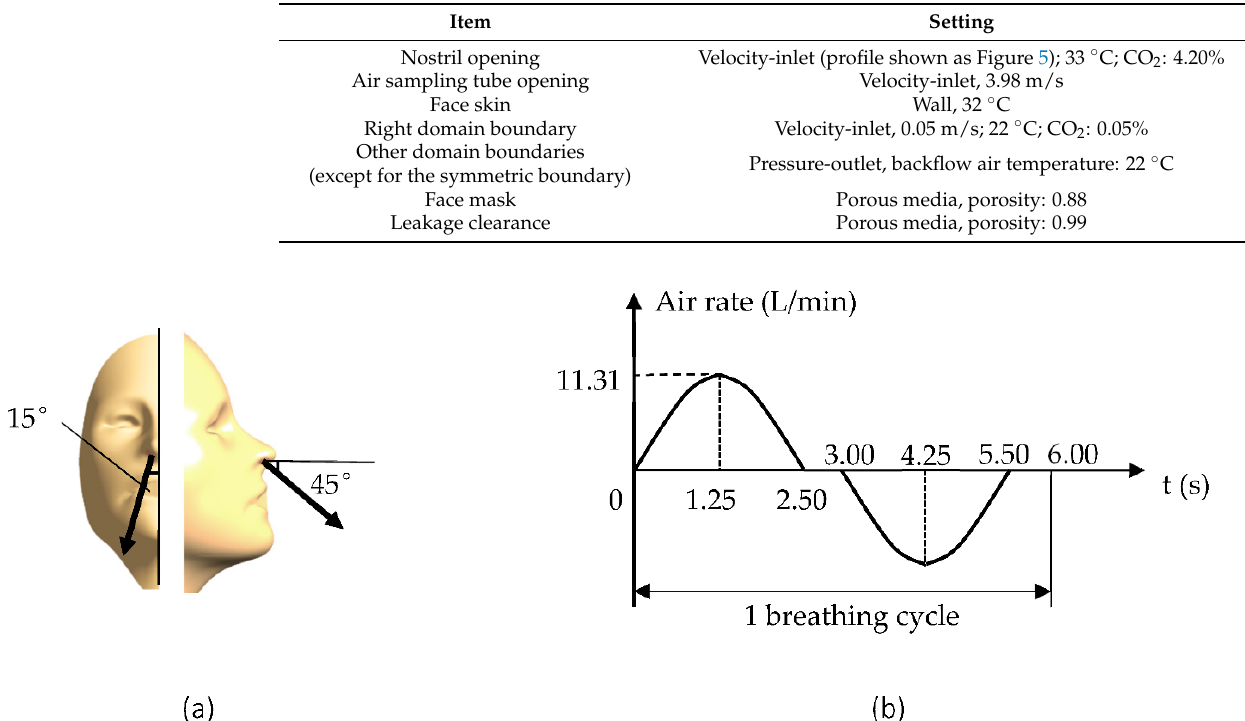
Table 1. Boundary conditions in CFD modeling.